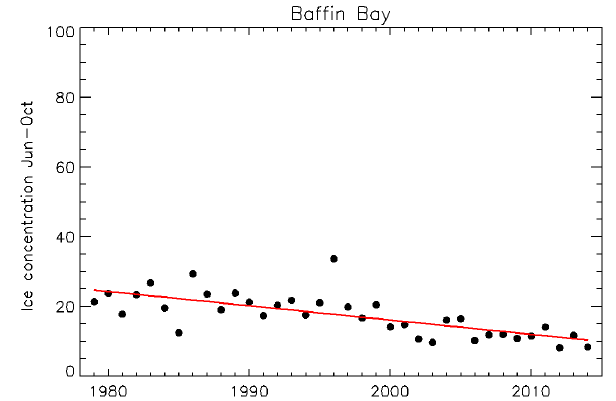
Figure 6. Summer (June through October) sea-ice concentration vs. year for Baffin Bay (all depths), with least-squares line in red (slope: − 4.1percentdecade − 1 ) . See Fig. S4 for similar plots for other re-